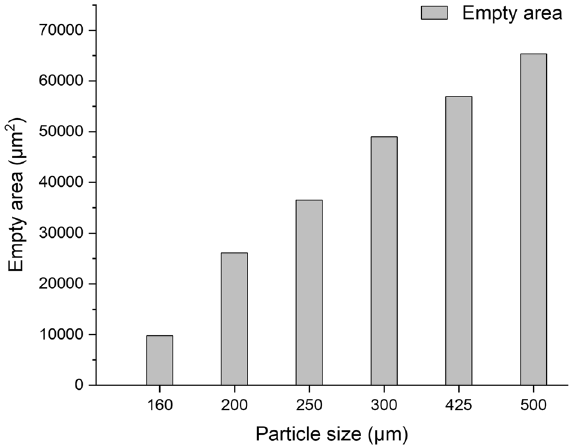
Figure 5. Evolution of the total empty area as a function of the particle size of the measured sample.